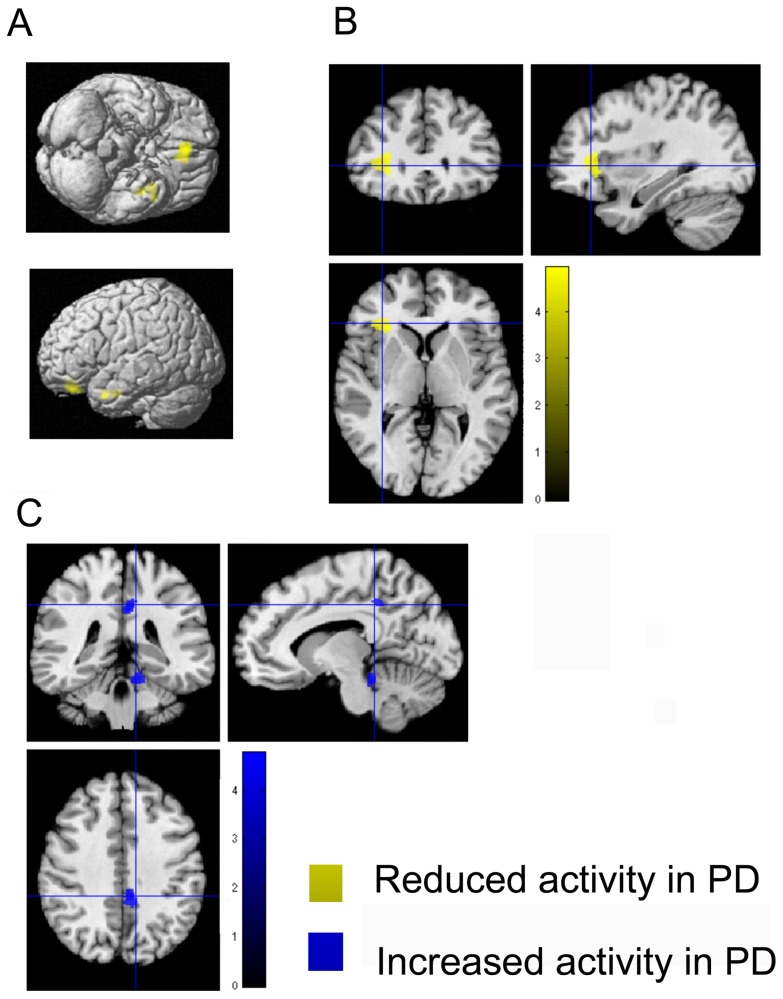
Functional working-memory related correlates in PD and controls during load-related modulation.
A–B) Regions showing significantly lower load-related modulation in PD during the encoding phase A) and delayed recall B). C) Regions showing significantly higher load-related modulation in PD relative to healthy controls during delayed recall. All significant effects are displayed on the MNI single subject template and the color bar represents T-values.